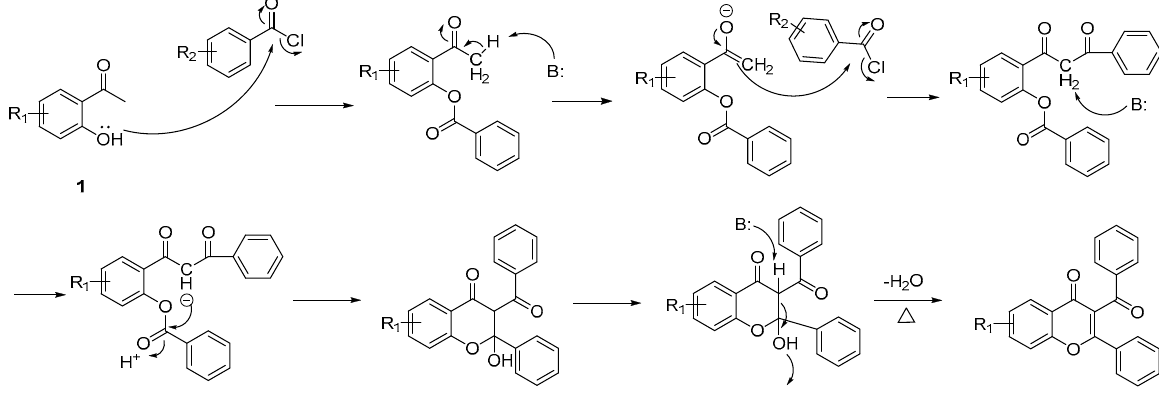
Figure 2. Purposed mechanism of chromone synthesis using modified Baker–Venkataraman reactions.